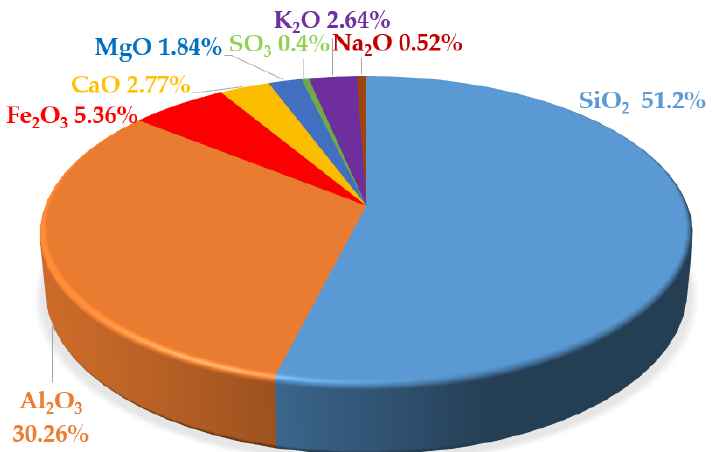
Figure 1. Chemical composition of Kozienice Fly Ash (on the basis of the data included in [30]). The compounds contained in the phase composition are listed in order of decreasing percentage share of FA weight.